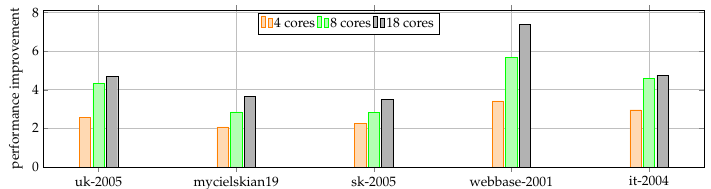
Figure 9. Improvement in performance of the parallel applications after applying Subscripted Subscript Analysis. Matrix Scaling applications after applying subscripted subscript